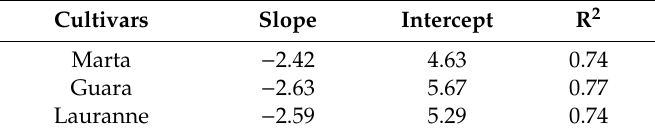
Table 6. Fitted parameters for the reference water-stress baselines (rWSB) for each cultivar.